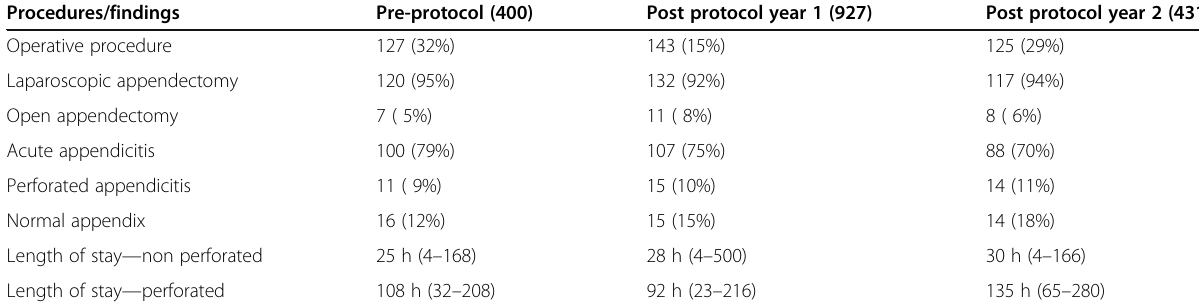
Table 3 Procedures and findings